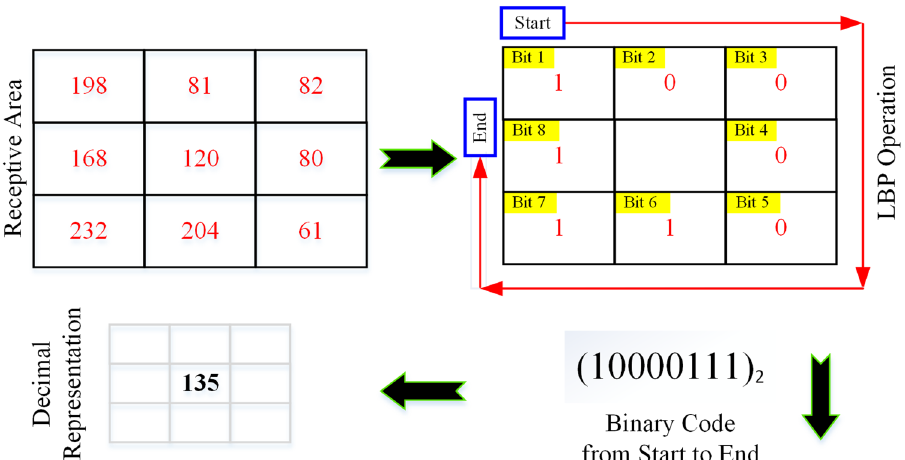
Figure 8. Schematic diagram of LBP operation to find the discriminative